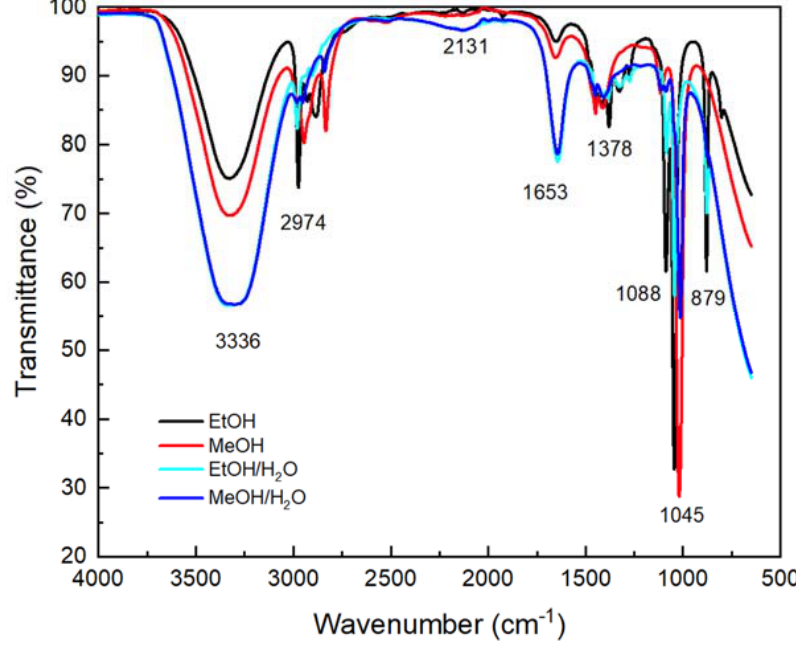
Figure 2. Plant extract FT-IR spectra from different types of solvents.